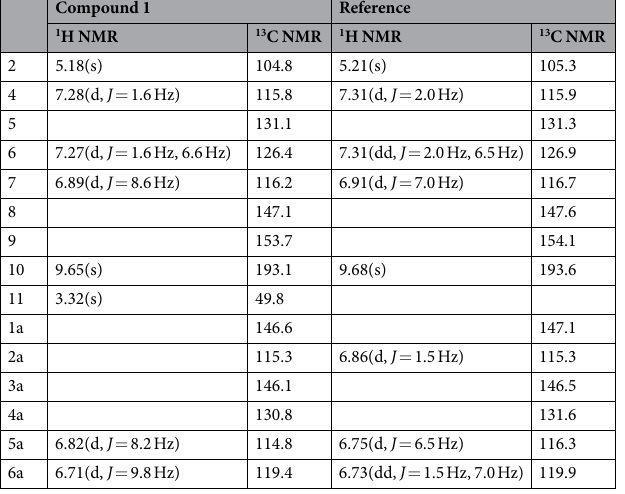
Table 1. 1H (500 MHz) and 13 C (125 MHz) NMR spectral data of compound 1 and Reference ( δ , ppm and J , Hz, CD 3 OD). Reference Tagashira et al . 35 reported.